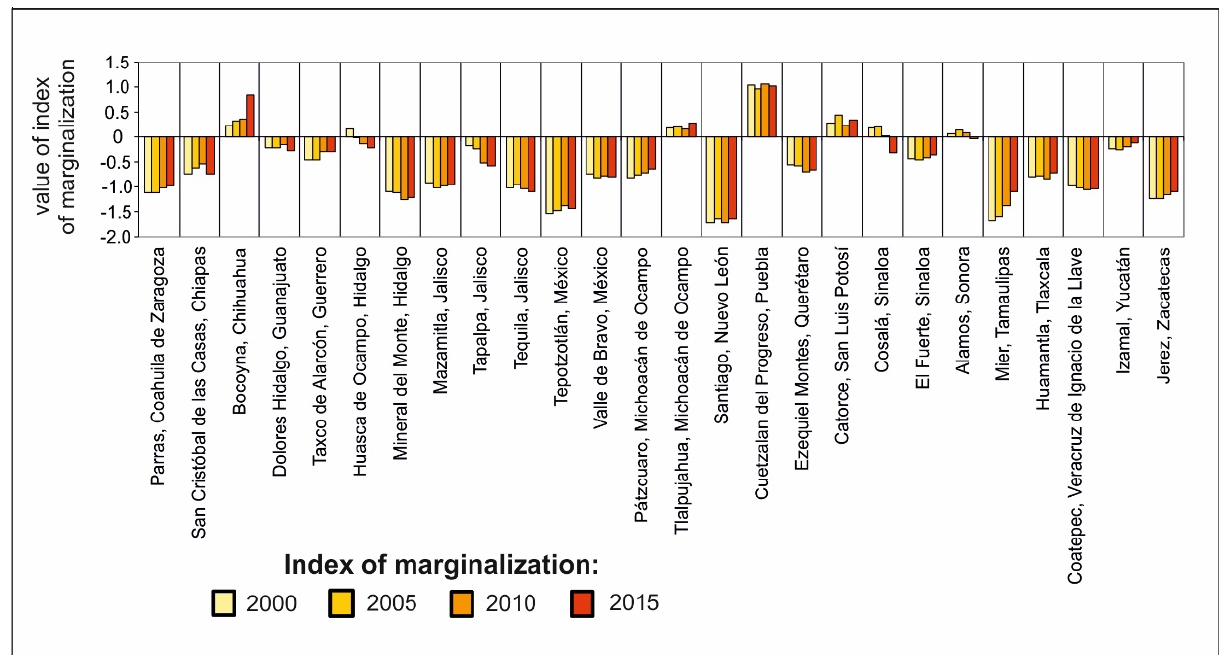
Figure 5. Index of marginalization in the years 2000, 2005, 2010 and 2015 for MPMs. Source: Author’s own compilation based on